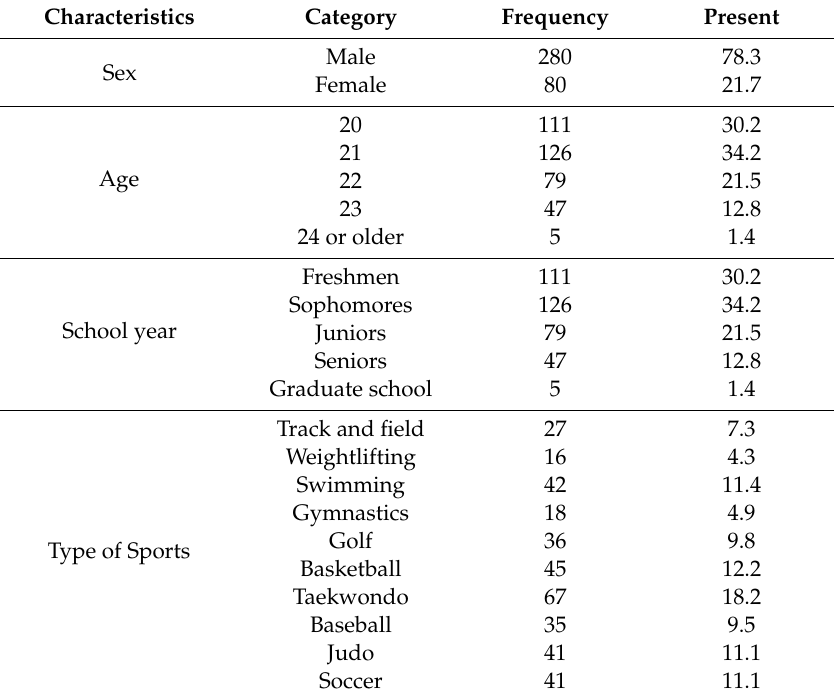
Table 1. General characteristics of the participants ( n =